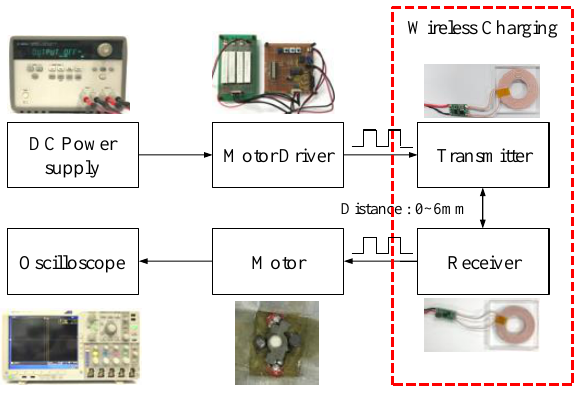
Figure 20. Schematic diagram of the wireless-driven, single-phase switched reluctance motor system.